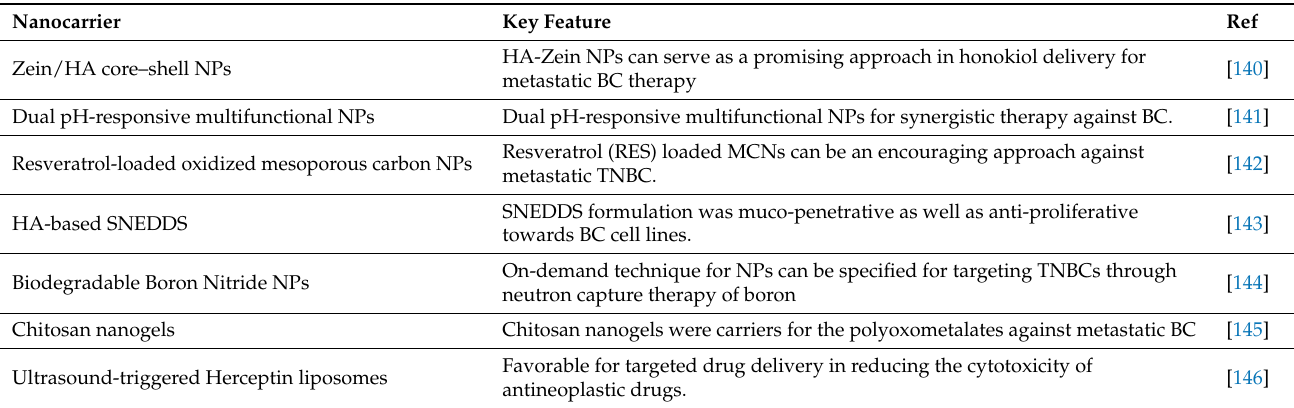
Table 1. Summary of multi-functionalized nanocarriers in treatment of